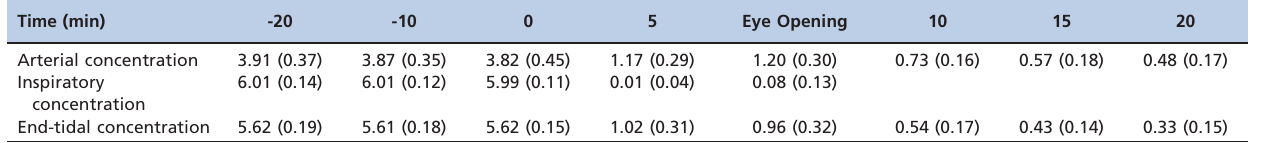
Table 2 - The arterial blood, inspiratory, and end-tidal concentrations of desflurane during emergence from general anesthesia in gynecologic patients (N =